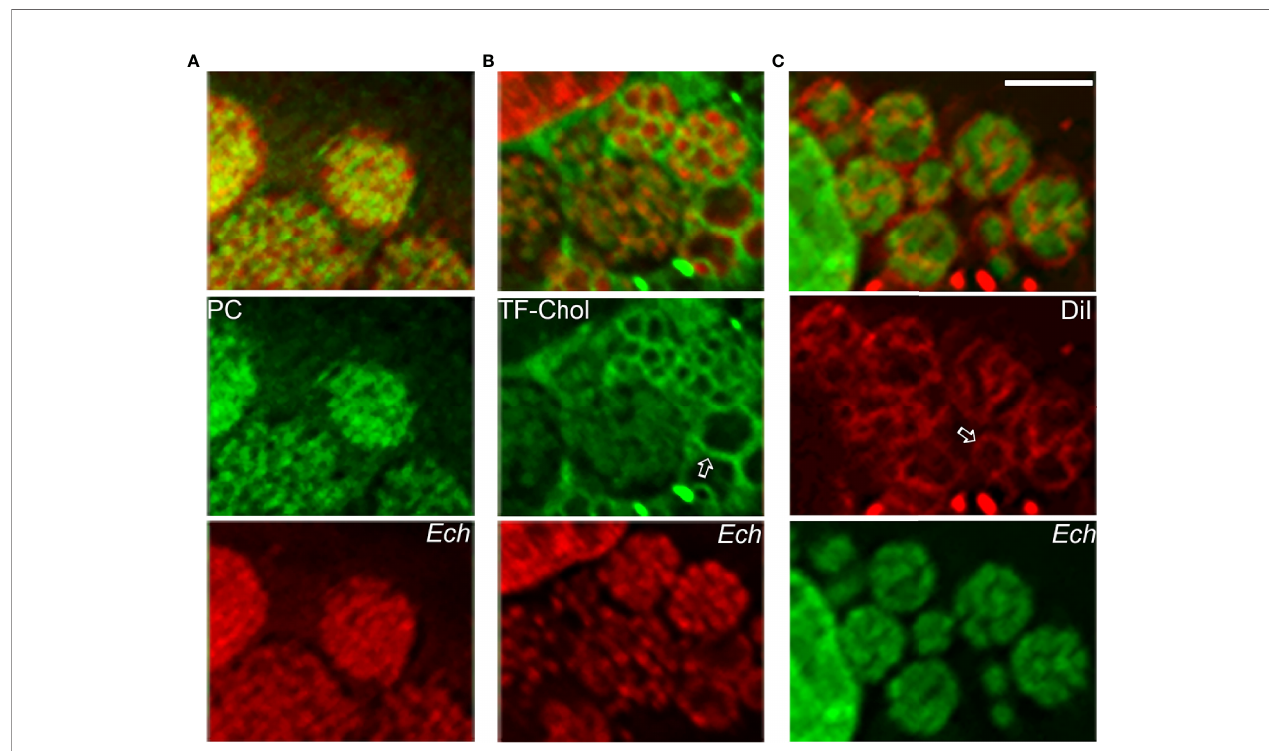
FIGURE 5 | Host-cell membrane lipids (cholesterol and glycerophospholipids) are traf fi cked to the membrane of E. chaffeensis and its inclusions. NBD- phosphatidylcholine (A) , TopFluor-cholesterol (B) , or DiI (C) is added to E. chaffeensis – infected RF/6A cells to monitor the intracellular distribution of the fl uorescent lipids. DNAs of bacteria and host are stained with Hoechst 33342 (pseudocolored green and red, respectively). Note labeling of densely packed intraluminal E. chaffeensis ( Ech , small cocci stained with Hoechst 33342) with the three fl uorescent lipids (A – C) and labeling of the bacterial inclusion membrane (open arrows) and intraluminal membranes with TopFluor-cholesterol (B) and DiI (C) . Bar: 3 µm. The drawing was modi fi ed from (Lin et al., 2020), copyright 2020